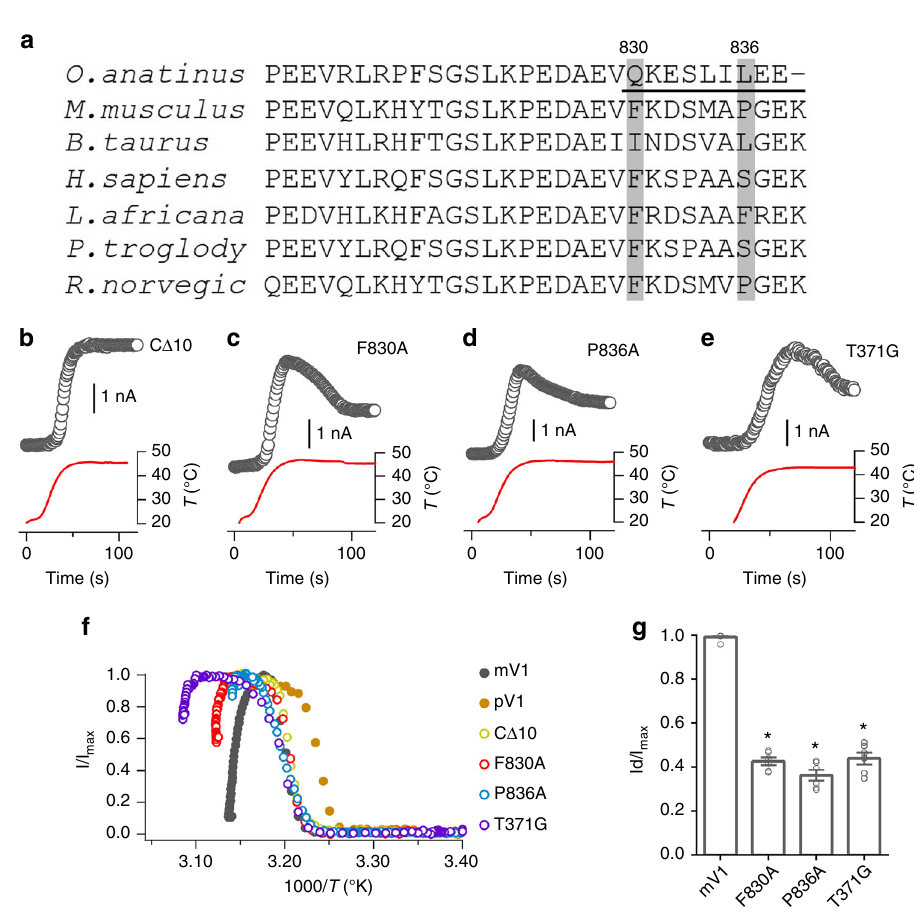
Fig. 2 N and C termini point mutants exhibit altered Dh transition of TRPV1. a The amino acid sequence representing C termini from pV1 is aligned with the corresponding sequences from other six mammal ’ s TRPV1. The species-speci fi c residues are indicated by gray background. b – e Representative currents induced by a temperature ramp recorded from HEK293T cells expressing C Δ 10 ( b ), F830A ( c ), P836A ( d ), and T371G ( e ) at + 80 mV. f Example heat- induced current responses from mV1, pV1, and the channel mutants. g The desensitized current (Id) of mV1 and mutants is normalized to maximum currents (Imax) induced by heating. n = 10 for mV1, n = 6 for F830A, n = 6 for P836A, n = 6 for T371G, two-sided t -test: * p < 0.01. Data are mean ± SEM. Source data are provided as a Source data fi